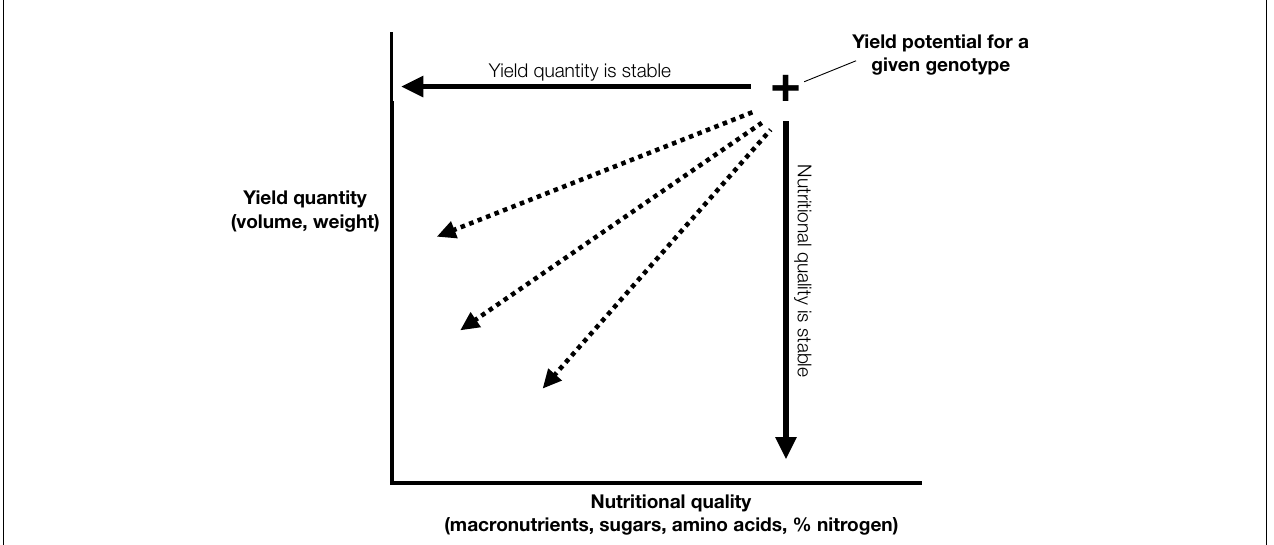
FIGURE 2 | Yield quantity and nutritional quality are interrelated determining the yield potential of a particular genotype.